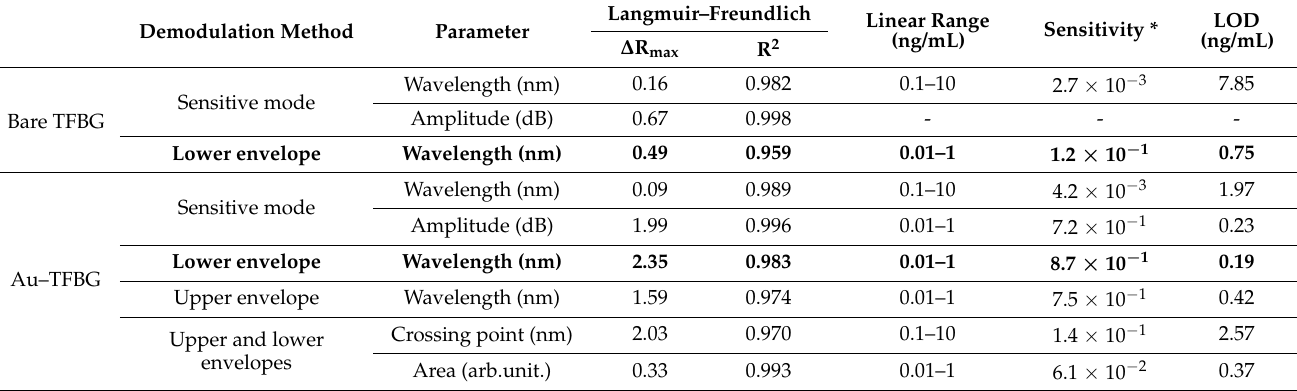
Table 1. Summary of the NT-proBNP detection results for bare and Au-coated TFBGs using the different demodulation methods. Results in bold represent the best achieved LODs for each